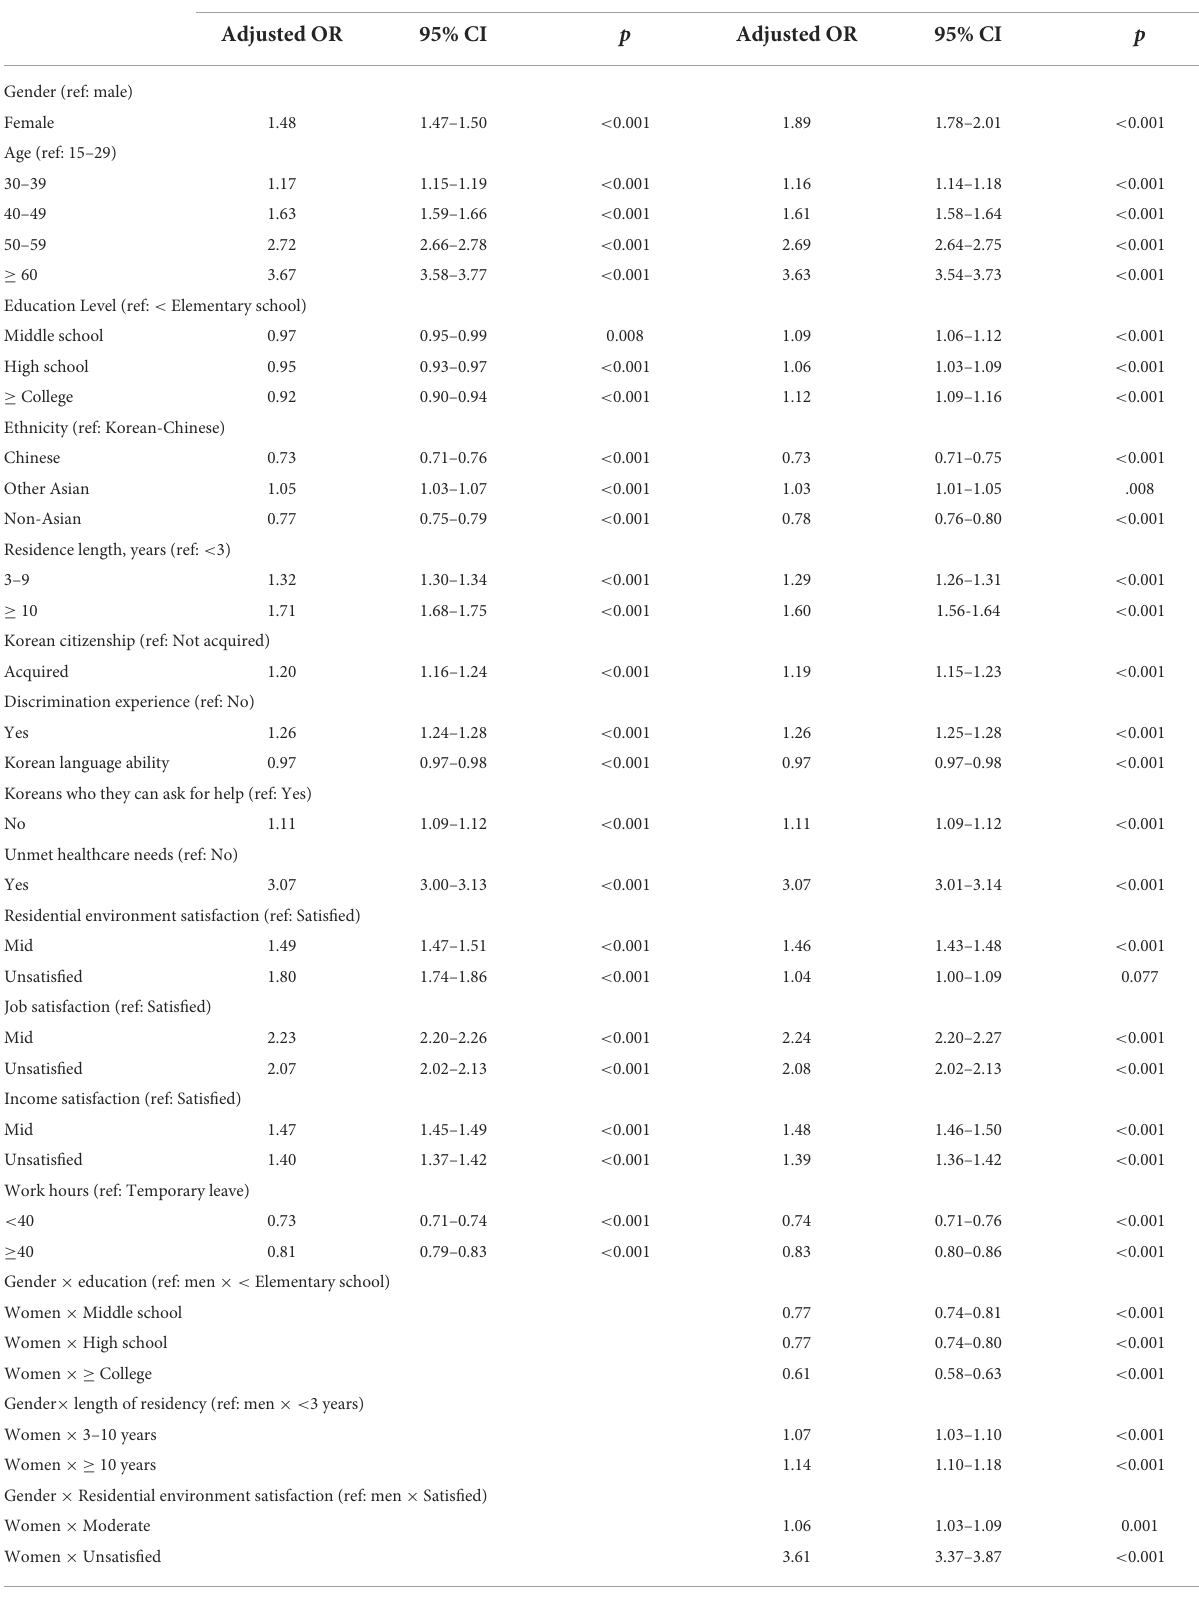
TABLE 2 Factors associated with the self-rated health of migrant workers with interactions. Variables Model 1 Model 2 Adjusted OR 95% CI p Adjusted OR 95%